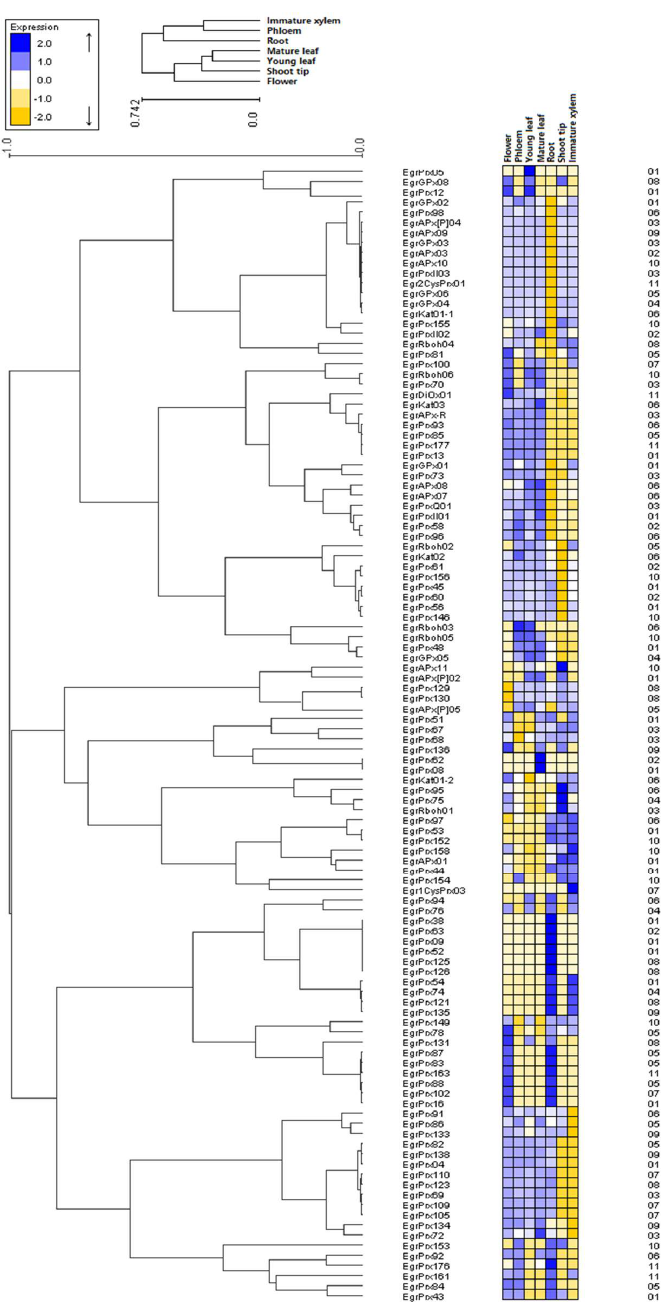
Figure 7. Heatmap of the expression of the ROS genes from E. grandis in different tissues. Each line represents a gene and each column represents a tissue. Mature leaf, young leaf, shoot tip, phloem, immature xylem, flower and root have been sampled and tested. The chromosome of each gene is written on the right.